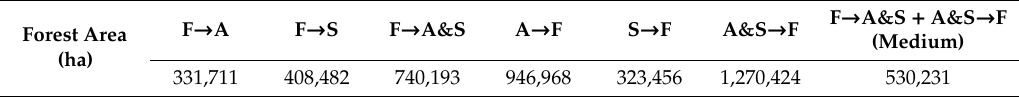
Table 1. Land area changes (ha) from forest (F) to agriculture (A) and settlements / other (S), from agriculture and settlements / other to forest across the Northern US every five